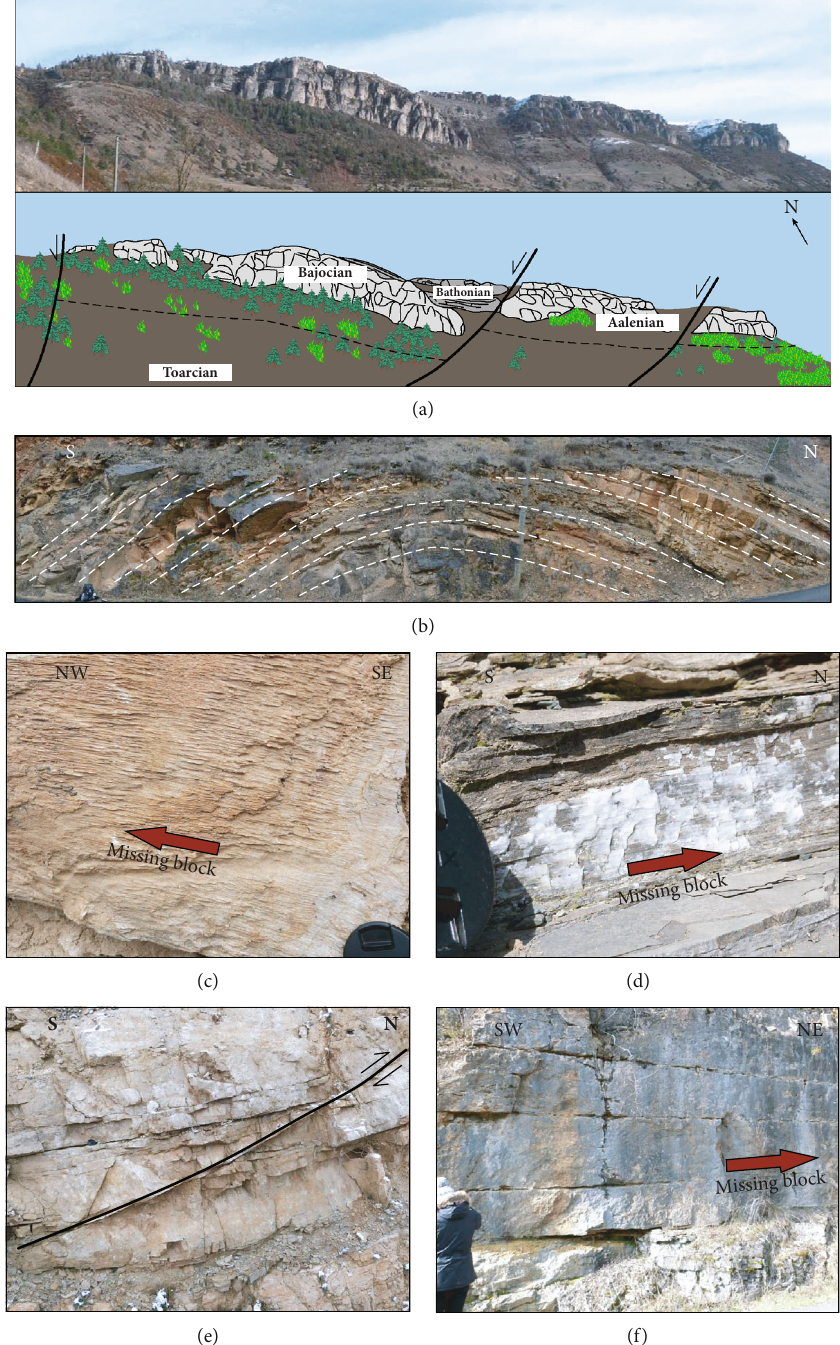
Figure 4: Examples of tectonic structures of the Grands Causses area. (a) Regional-scale Meyrueis normal fault network (Figure 2, N44 ° 12 ′ – E3 ° 25 ′ ). (b) East-west fold associated with north-south compression. (c, d) Tectoglyphs on fault mirror ((c) stylolithic peaks; (d) slicken fi bres on a fault plane). (e, f) Fault planes at outcrop scale ((e) reverse fault; (f) strike-slip